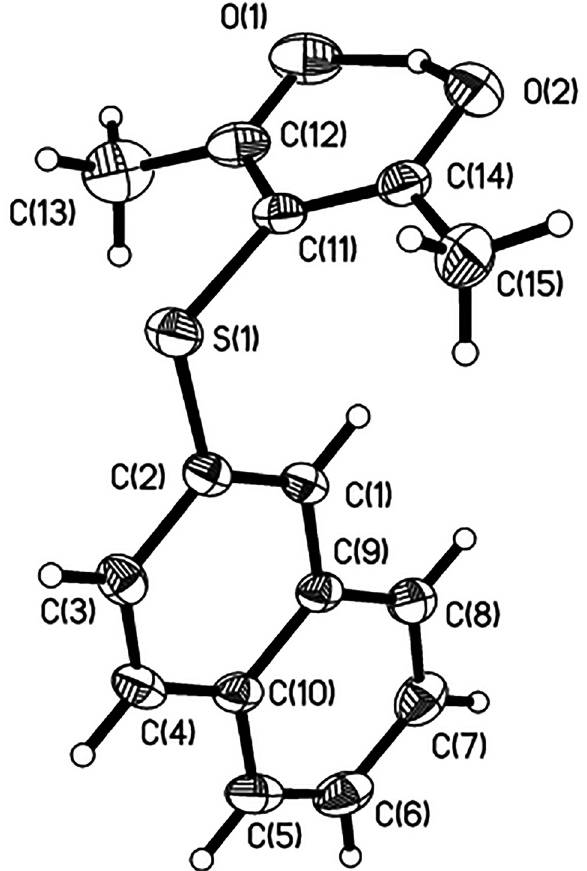
Table  : Data collection and